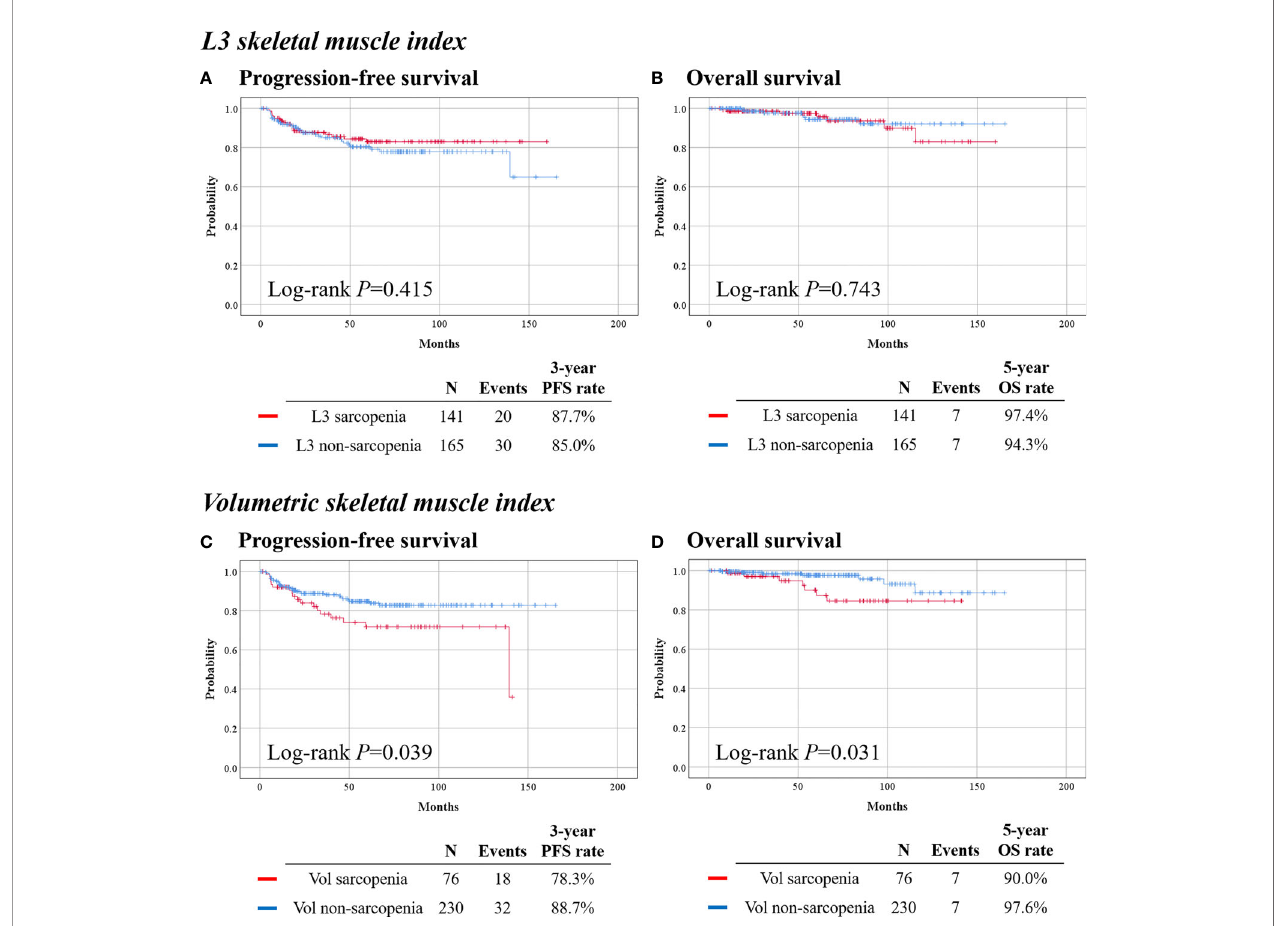
FIGURE 2 | Survival outcomes of patients by skeletal muscle index. (Top) Calculated from L3 level cross-sectional image. (Bottom) Calculated from volumetric measurement of the waist. (A, C) Progression-free survival. (B, D) Overall